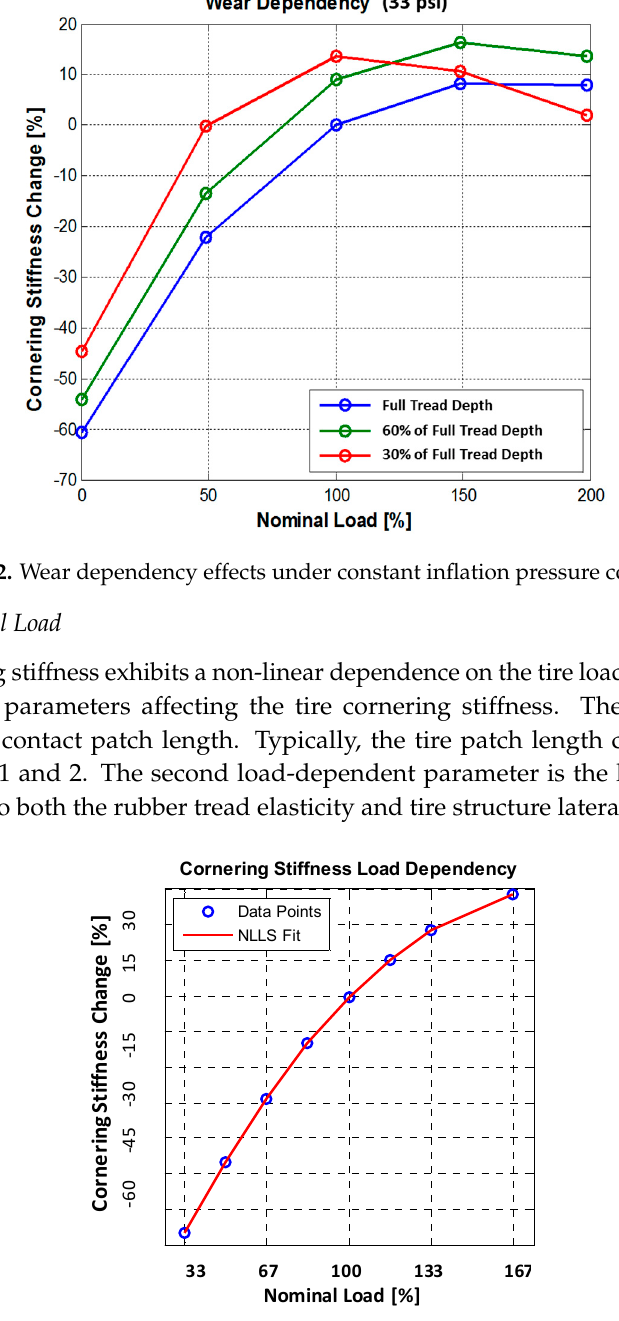
Figure 13. Influence of normal load on the tire cornering stiffness.